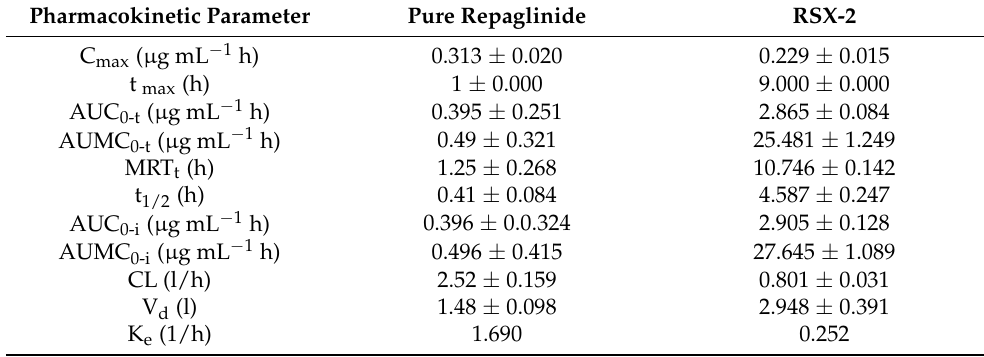
Table 8. Pharmacokinetic parameters for repaglinide solution and test (RSX-2) preparations. Pharmacokinetic